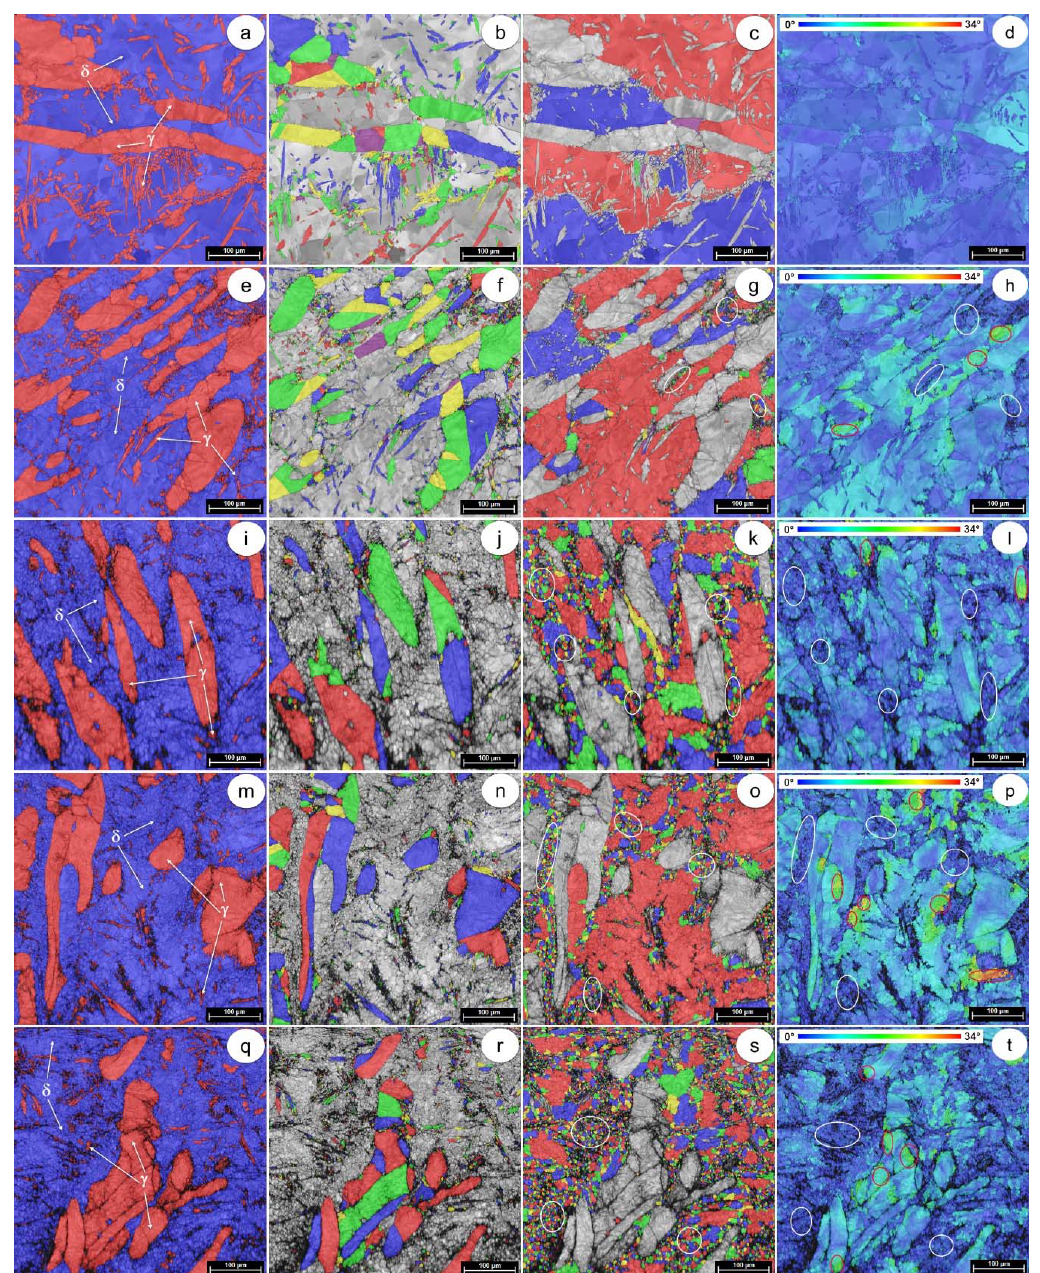
Figure 5. SEM-EBSD composite images for the UNS 32750 alloy deformed at 1300 ◦ C by ε = 10%: γ Figure 5. SEM ‐ EBSD composite images for the UNS 32750 alloy deformed at 1300 °C by ε = 10%:  and δ phase distribution ( a ); grain size, shape and distribution for  ‐ phase ( b ) and  ‐ phase ( c ); GROD and δ phase distribution ( a ); grain size, shape and distribution for γ -phase ( b ) and δ -phase ( c ); GROD map distribution for both  and  phases ( d ); ε = 20%:  and δ phase distribution ( e ); grain size, shape map distribution for both γ and δ phases ( d ); ε = 20%: γ and δ phase distribution ( e ); grain size, shape and distribution for  ‐ phase ( f ) and  ‐ phase ( g ); GROD map distribution for both  and  phases ( h ); and distribution for γ -phase ( f ) and δ -phase ( g ); GROD map distribution for both γ and δ phases ( h ); ε = 30%:  and δ phase distribution ( i ); grain size, shape and distribution for  ‐ phase ( j ) and  ‐ phase ε = 30%: γ and δ phase distribution ( i ); grain size, shape and distribution for γ -phase ( j ) and δ -phase ( k ); GROD map distribution for both  and  phases ( l ); ε = 40%:  and δ phase distribution ( m ); grain ( k ); GROD map distribution for both γ and δ phases ( l ); ε = 40%: γ and δ phase distribution ( m ); grain size, shape and distribution for  ‐ phase ( n ) and  ‐ phase ( o ); GROD map distribution for both  and  size, shape and distribution for γ -phase ( n ) and δ -phase ( o ); GROD map distribution for both γ and δ phases ( p ); ε = 50%:  and δ phase distribution ( q ); grain size, shape and distribution for  ‐ phase ( r ) phases ( p ); ε = 50%: γ and δ phase distribution ( q ); grain size, shape and distribution for γ -phase ( r ) and  ‐ phase ( s ); and, GROD map distribution for both  and  phases ( t ). and δ -phase ( s ); and, GROD map distribution for both γ and δ phases ( t